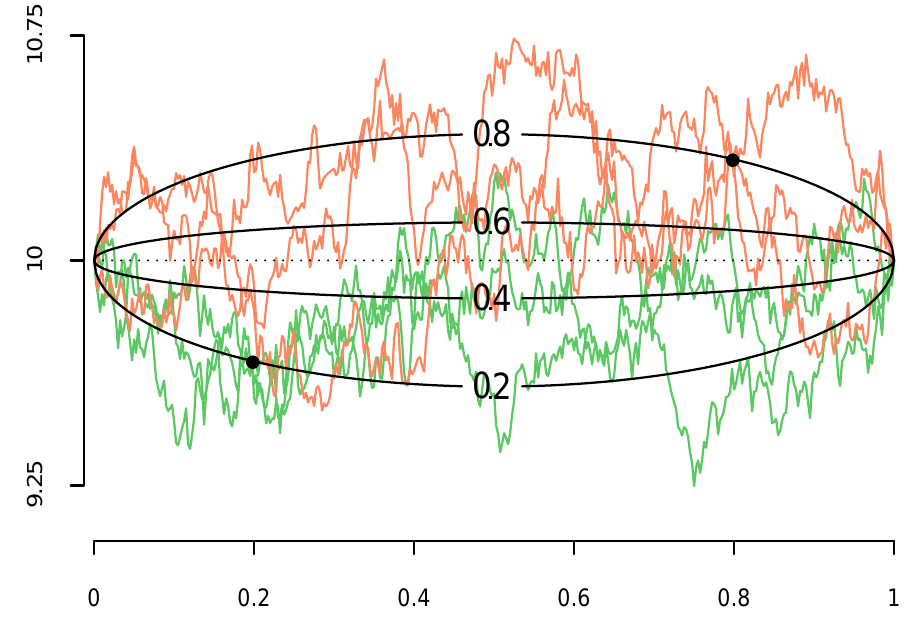
( q ) ( 0, t ( 1 t )) , the marginal is the q -quantile of a t N − ) 1 ) 1 X 0.2 = X ( 0.2 ) X 0.8 = X ( 0.8 ) and ( X t respectively, t = 0 t = 0 0.2 0.8 | |